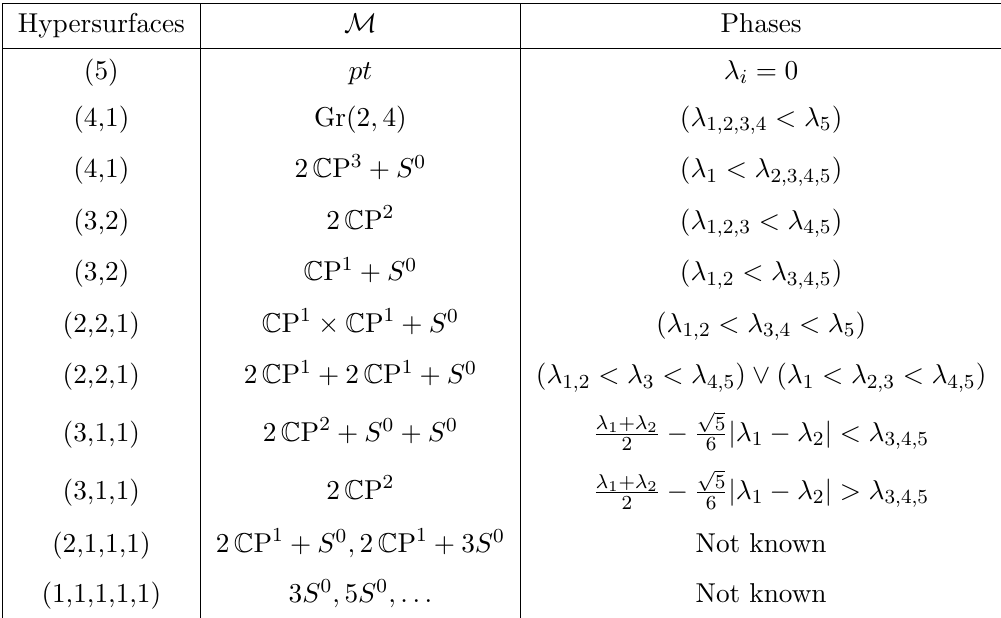
Table 1 . The structure of moduli spaces of vacua for the mass deformed Each phase has been labeled by a sequence indicating the order of distinct eigenvalues of M . Here S 0 means two isolated vacua related by time reversal. For the last two phases, the vacuum equations cannot be solved analytically and the results are presented from numerical